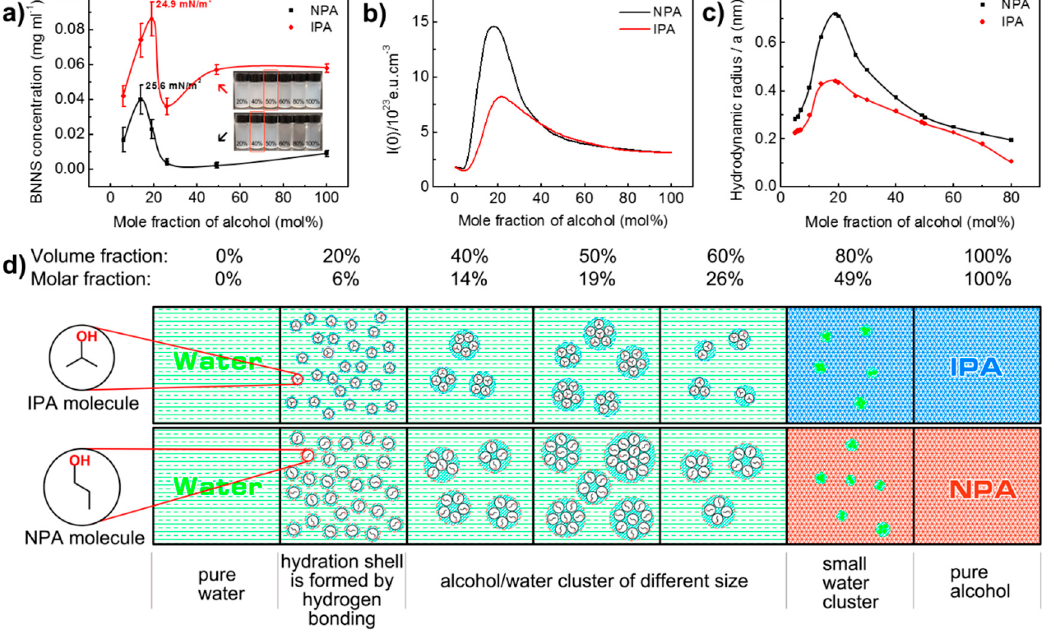
Figure 4. Analysis of water/1,2-propanol co-solvent exfoliation of h -BN into BNNSs. ( a ) The influence of water/1,2-propanol co-solvent formulations on concentration of exfoliated BNNSs. Digital photos in this figure are exfoliated BNNS suspensions in 10 mL glass bottles (volume fraction is marked on bottles). ( b ) Dependence of the zero-angle X-ray scattering intensity on different formulations of water/1,2-proponal co-solvent. Adapted with permission from [53]. Copyright (1990) American Chemical Society. ( c ) Hydrodynamic radius of water/1,2-propanol co-solvent clusters. ( d ) Schematic diagram of the evolution of water/1,2-propanol co-solvent clusters.